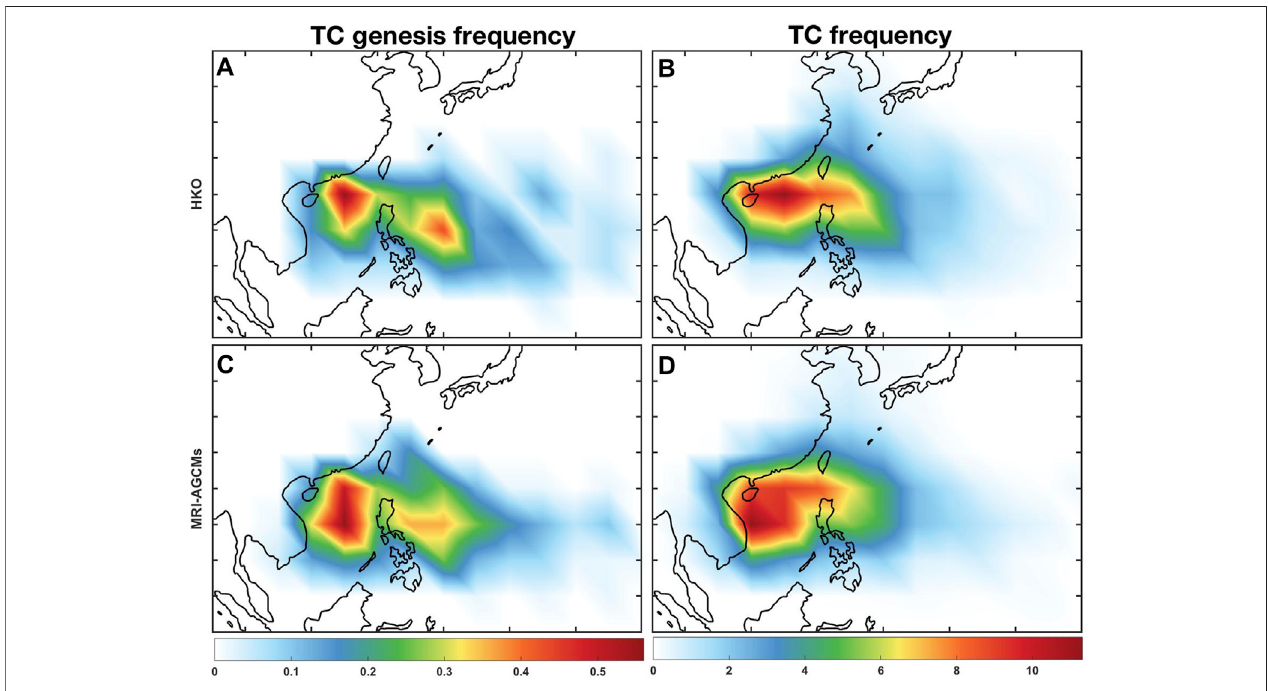
FIGURE6| Comparisonsofobserved (A,B) andMRI-AGCM3.2s – simulated (C,D) WNPland-fallingTCsgenesisfrequency (A,C), andoccurrencefrequency (B,D) in the period between 1979 and 2003.